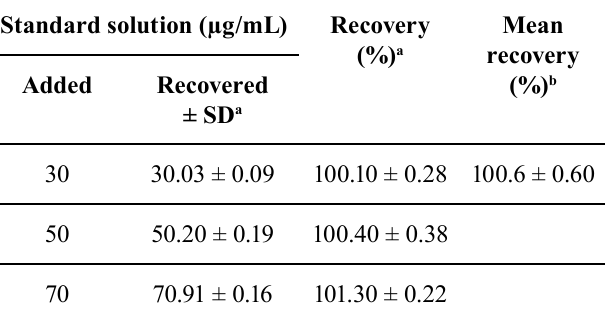
TABLE I – R ecovery results for MEKC method